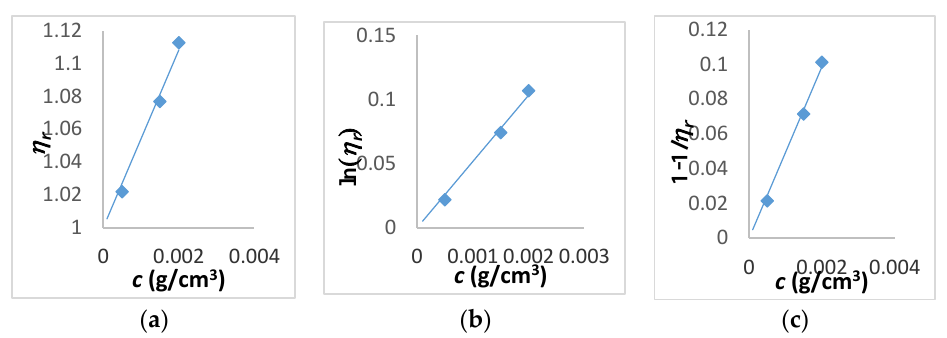
Figure 5. Tanglertpaibul & Rao plots for ( a – c ) equations. Where ( a ) is η r vs. c , ( b ) is ln η r vs. c , and ( c ) is 1 − 1/ η r vs. c .